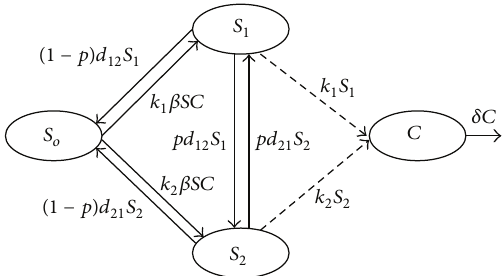
Figure 1: Coopetition diagram of two